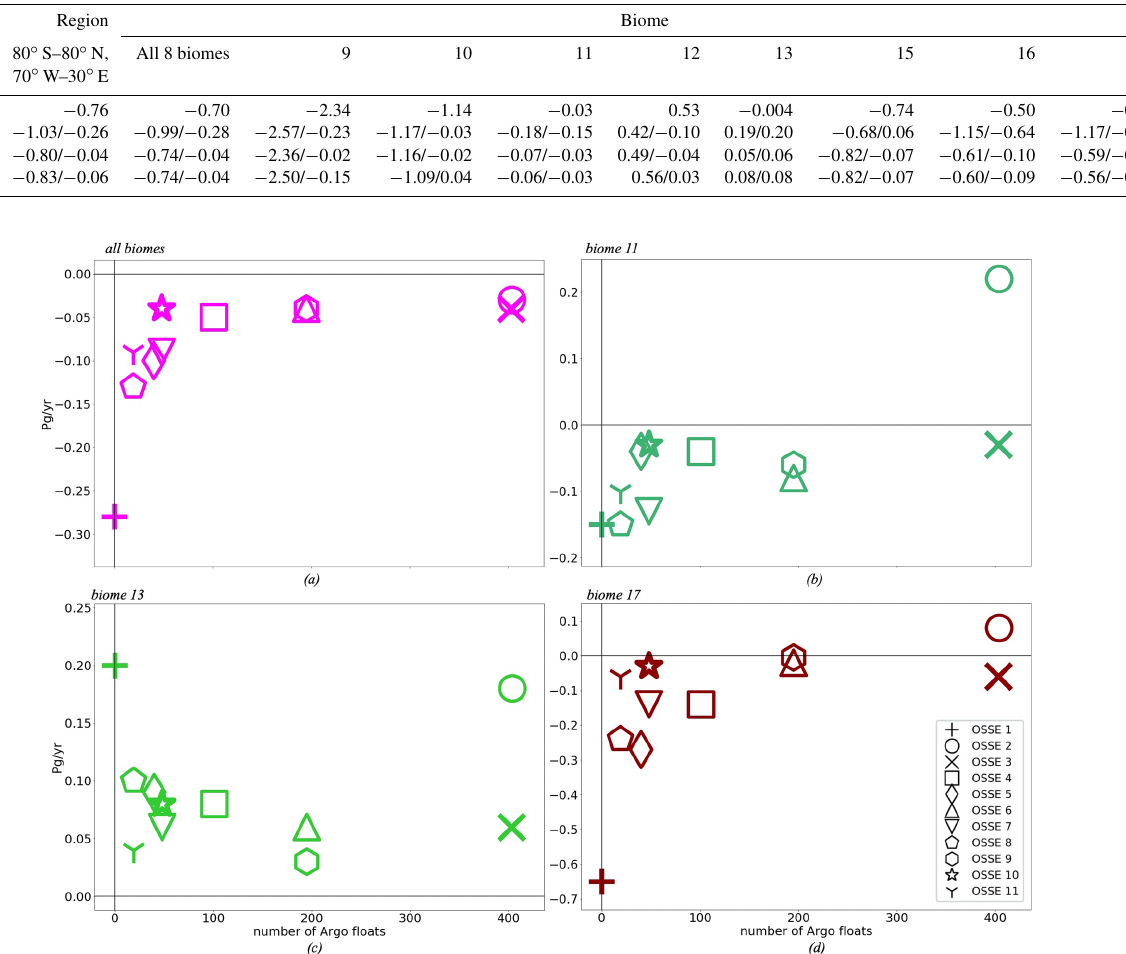
Figure 9. Averaged number of Argo profiles per 5d time step over 2008–2010 versus averaged differences between each OSSE fg CO 2 and NEMO fg CO 2 (in Pgyr − 1 ), the colour code corresponds to Fig. 2, the purple colour represents the total of the eight biomes: (a) all biomes, (b) biome 11 (subtropical permanently stratified North Atlantic), (c) biome 13 (subtropical permanently stratified South Atlantic), and (d) biome 17 (Southern Ocean ice). OSSE 1 uses SOCAT data only; OSSE 2 uses synthetic Argo data only; OSSE 3 uses SOCAT and synthetic Argo data; OSSE 4 uses SOCAT data and 25% of the original synthetic Argo data; OSSE 5 uses SOCAT data and 10% of the original synthetic Argo data; OSSE 6 uses SOCAT data and synthetic Argo data in the Southern Hemisphere; OSSE 7 uses SOCAT data and 25% of the original synthetic Argo data in the Southern Hemisphere; OSSE 8 uses SOCAT data and 10% of the original synthetic Argo data in the Southern Hemisphere; OSSE 9 uses SOCAT data, synthetic Argo data in the Southern Hemisphere, and data from mooring stations; OSSE 10 uses SOCAT data, 25% of the original synthetic Argo data in the Southern Hemisphere, and data from mooring stations; OSSE 11 uses SOCAT data, 10% of the original synthetic Argo data in the Southern Hemisphere, and data from mooring stations. OSSEs 1, 3 and 10 are in bold as they represent the main OSSEs of our